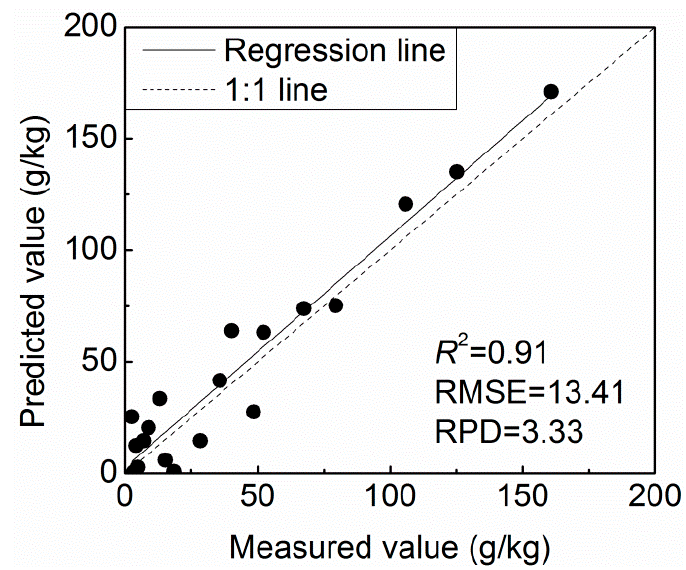
Figure 6. Comparison of estimated and measured values of SOM content by partial least squares